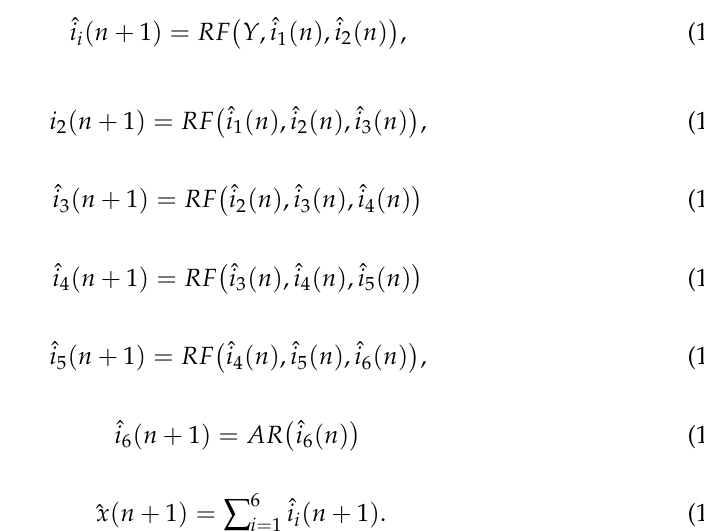
7 of 15 Algorithm 3: RF–IMF prediction model